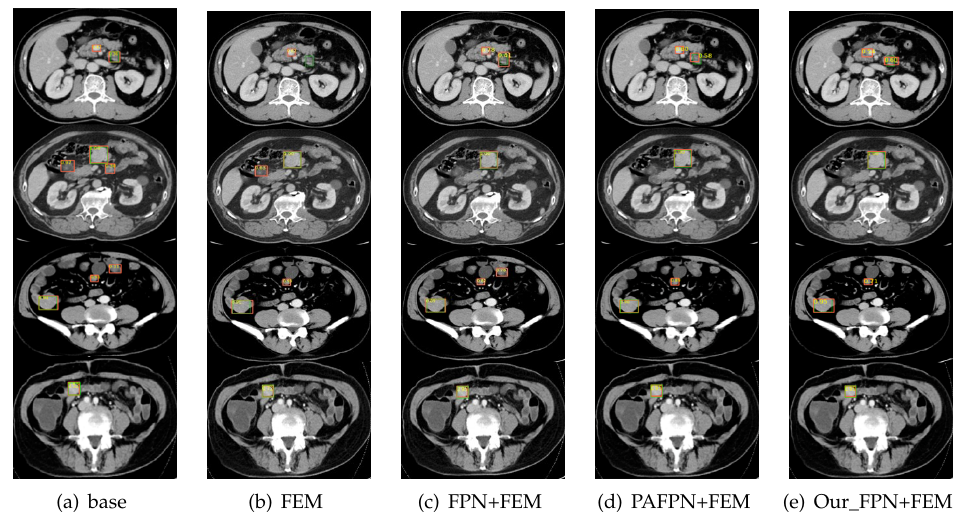
Figure 5. Visual comparison of the FEM combined with the different feature pyramid networks (the orange bounding box in the figure represents the predicted box, and the green bounding box represents the actual labeled